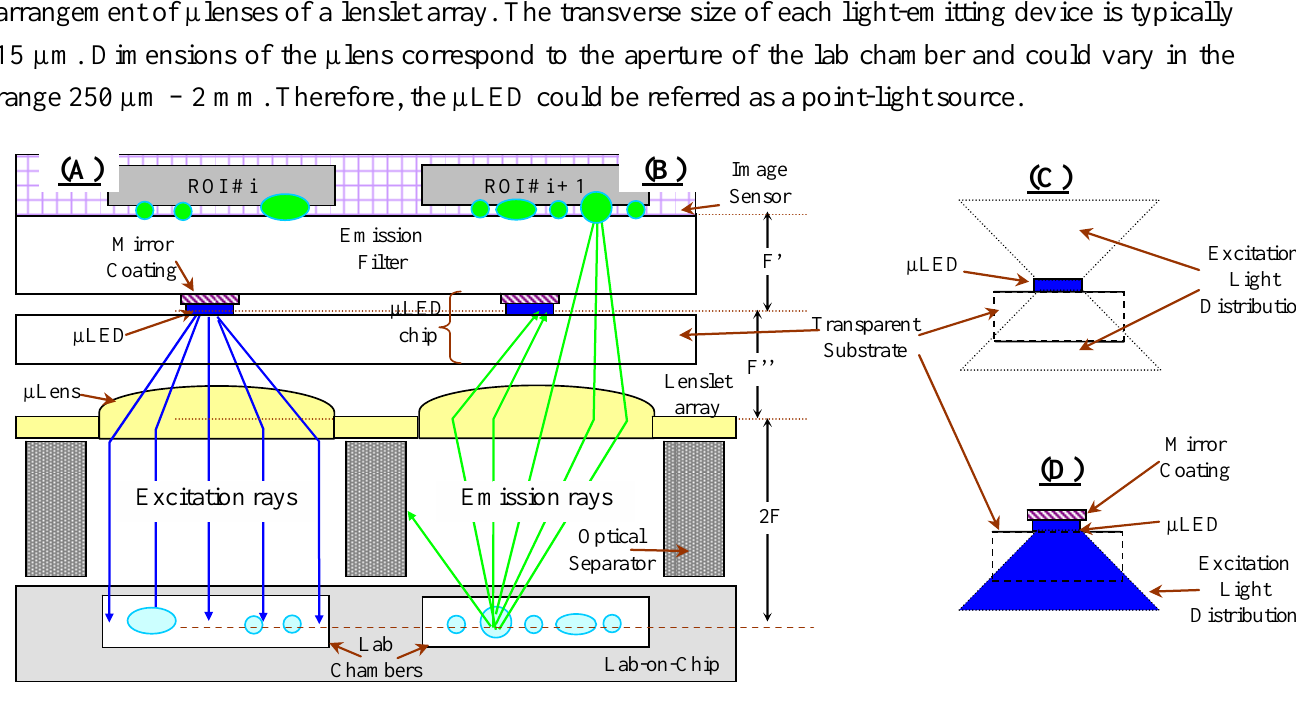
Figure 2. Transparent µLED chip 180º utilization with lab-on-chip